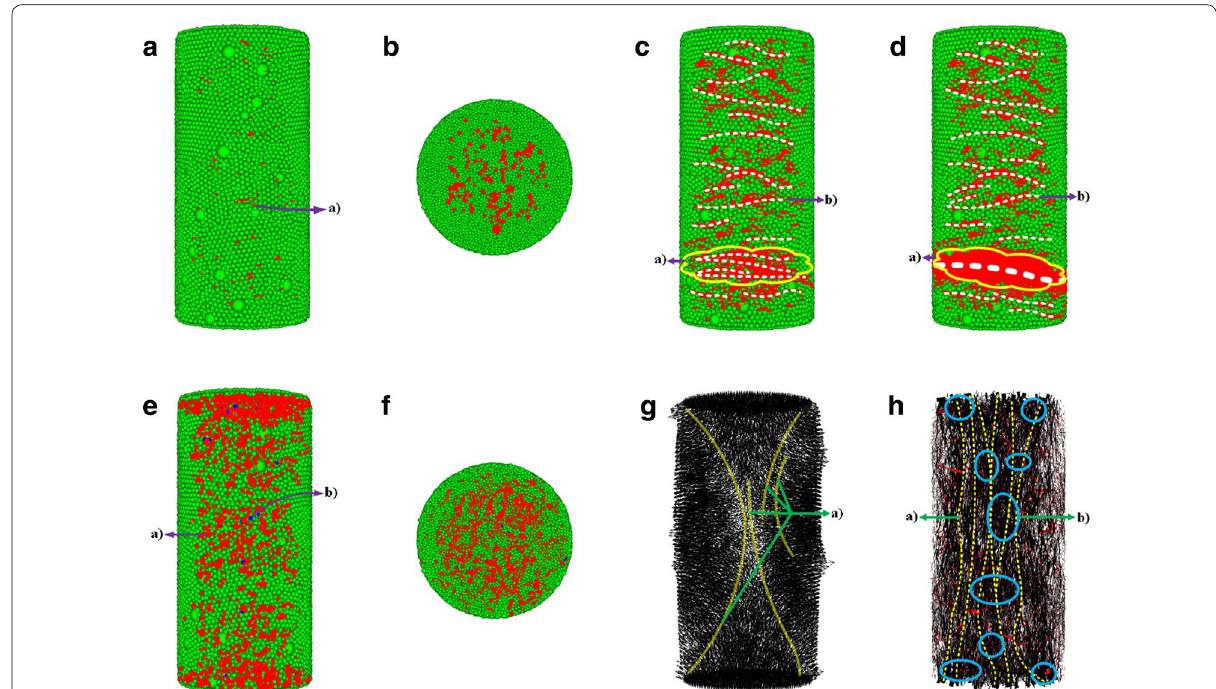
Fig. 10 Crack development of specimens at different loading stages. a The state of crack propagation under tension. a) Represents normal failure of a bond, b the state of crack propagation under tension (top view), c the state of peak strain under tension. a) and b) Represent the locations of main failure faces and other failure faces, respectively, d the state of triple peak strain under tension. a) and b) Represent the locations of main failure faces and other failure faces, respectively, e the state of crack propagation under compression. a) and b) Represent normal and shear failure of a bond, respectively, f the state of crack propagation under compression (top view), g the state of triple peak strain under compression (displacement vector diagram). a) Represents the main fault zones, h the state of triple peak strain under compression (Force chains diagram). a) and b) Represent the main load-transfered paths and the stress concentration zones,